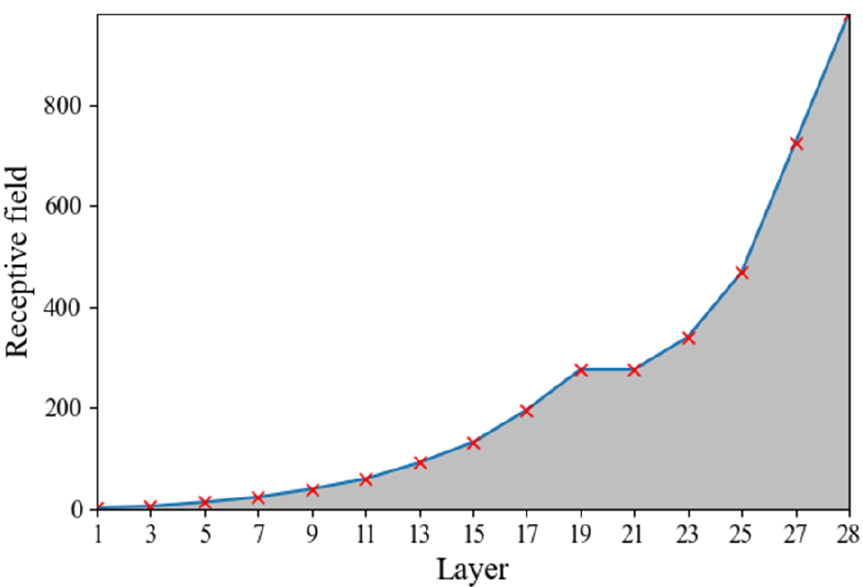
Figure 2. SSD theoretical receptive field size.